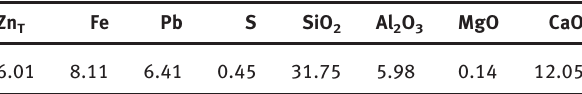
Table 1: Main chemical composition of low-grade oxide zinc ores (mass fraction, %).